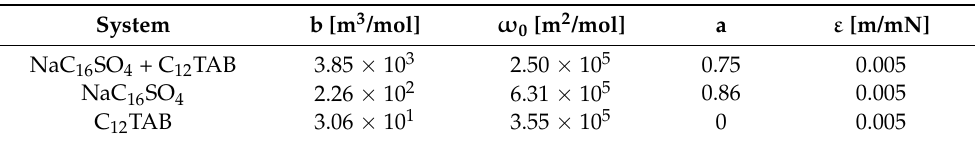
Figure 4. Equilibrium interfacial tension measured by profile analysis tensiometry (PAT) at the solution/hexane interface as a function of the total bulk concentration c of the mixtures ( (cid:7) ) NaC 16 SO 4 + C 12 TAB and the individual surfactants ( (cid:4) ) NaC 16 SO 4 and ( ) C 12 TAB; the solid lines are the fitting results for a Frumkin adsorption model given by Equations (1)–(3). Table 4. Parameter values obtained by fitting the Frumkin adsorption model Equations (1)–(3) to the experimental data of Figure 4.